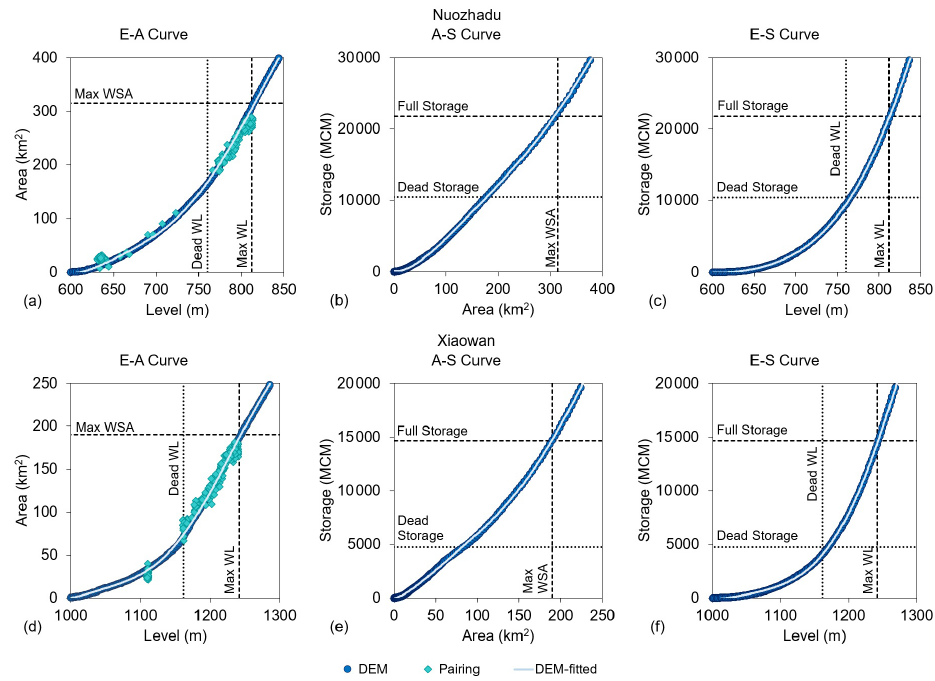
Figure 7. E – A , A – S , and E – S curves of Nuozhadu (a–c) and Xiaowan (d–f) reservoirs. The curves are represented by light blue lines, which are fitted to the data points (blue circles) derived from the DEM data. Note that the curves intersect the points identified by maximum water level, maximum water surface area, and full-storage volume (dashed lines) as well as those identified by dead water level and dead-storage volume (dotted lines). The cyan diamonds reported in panels (a) and (d) correspond to observations of water level and surface area obtained from altimetry data and Landsat imagery.